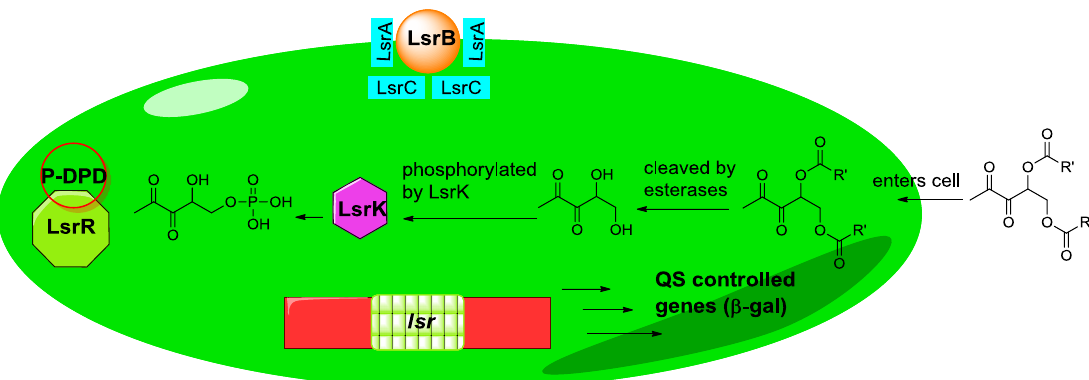
Figure 6. Proposed model of action in enteric bacteria. Ester protected DPD analogs diffuse into the cell, where esterases hydrolyze the ester pro-DPD and analogs and the DPD or analogs are subsequently phosphorylated by